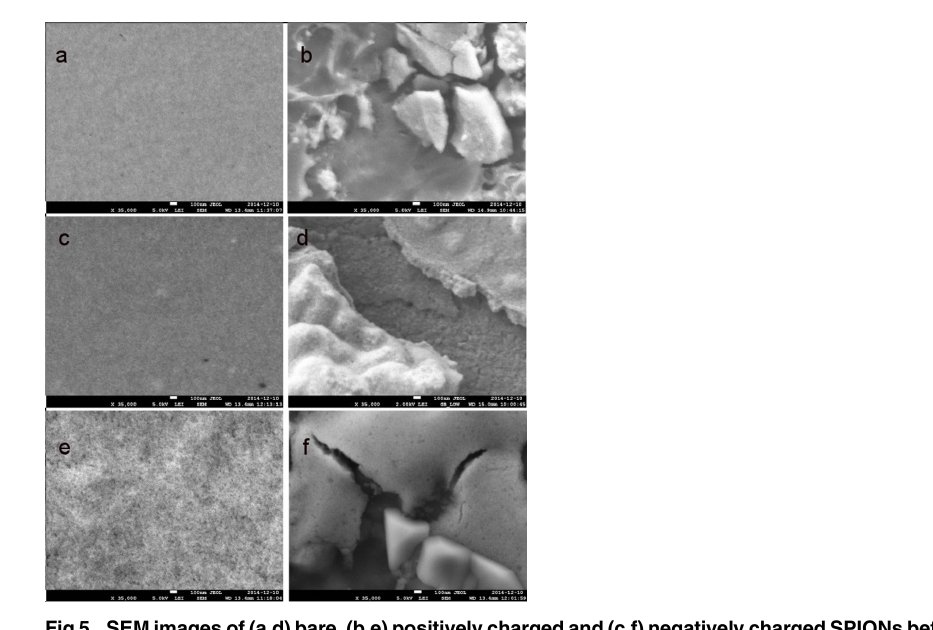
Fig 5. SEM images of (a,d) bare, (b,e) positively charged and (c,f) negatively charged SPIONs before and after incubation with the biofilms. Following incubation with the bacterial biofilms, the SPIONs appeared to be coated with soft